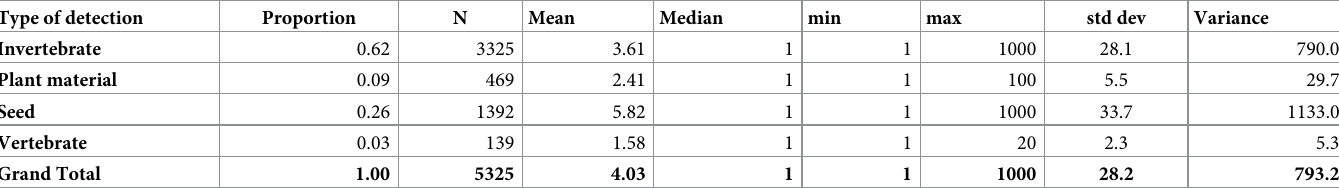
Table 2. Summary statistics for the Barrow Island biosecurity detection events between 2009 and 2015.